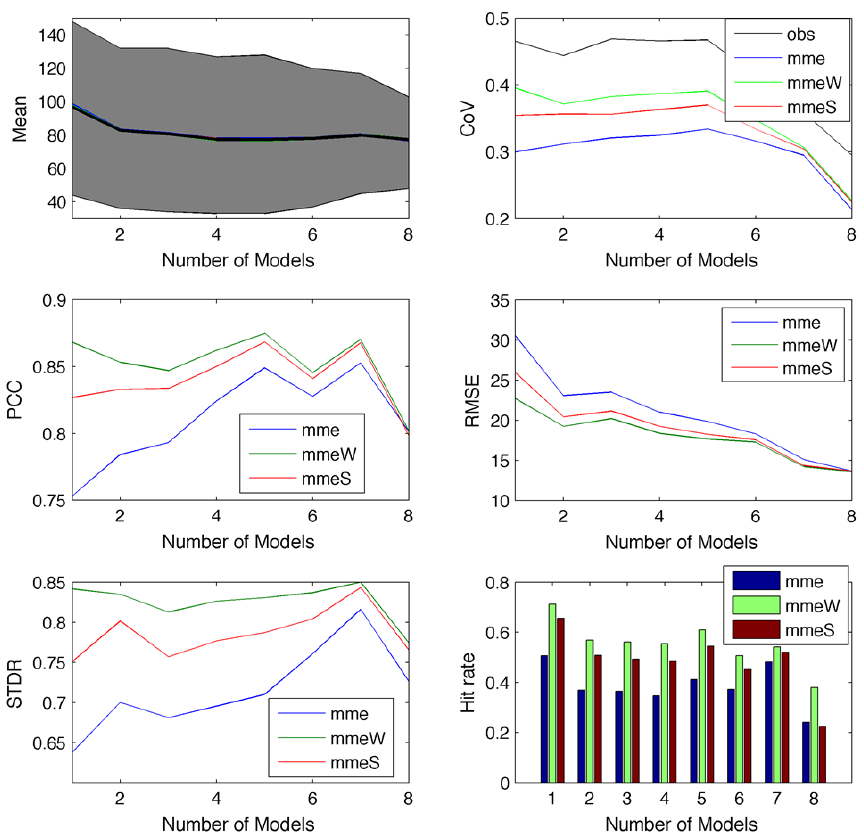
Figure 11. Top: statistical properties of mme, mmeS and mmeW forecasts versus observations from the 451 stations for the test data set as a function of M eff : (a) mean and (b) coefficient of variation (SD/Mean). The shadow area in the mean plot shows the 10th and 90th percentile of the observed concentrations. Middle/bottom: forecast skill of mme, mmeS and mmeW from the 451 stations for the test data set as a function of M eff : (c) PCC, (d) RMSE, (e) STDR (standard deviation ratio) and (f) Hit